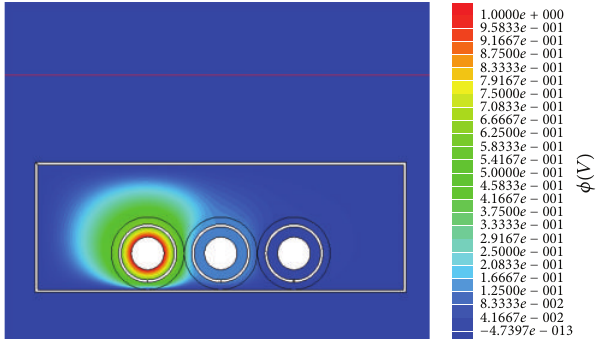
Figure 5: One screenshot of the FEM analysis for determining the parameters.